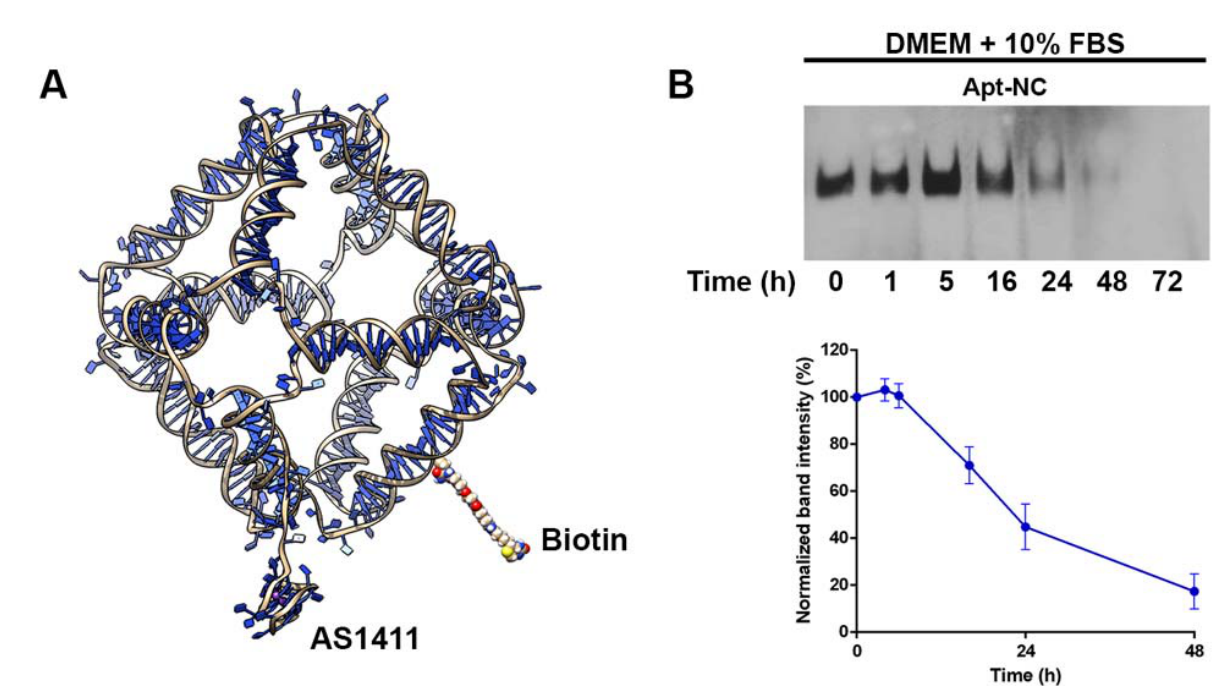
Figure 1. ( A ) Schematic representation of the Apt-NC nanostructure model. ( B ) DNA blot analysis of Apt-NCs incubated in DMEM supplemented with 10% FBS at 37 ◦ C for different times, as indicated. Apt-NCs before incubation with serum proteins are indicated as time 0. Biotinylated Apt-NCs were detected with streptavidin–HRP. The graph shows the densitometric analysis of three different experiments, performed using the ImageJ software. The relative intensity of each band was normalized to the intensity of the band corresponding to time 0 and reported in the graph. Values are expressed as an average ± SEM.